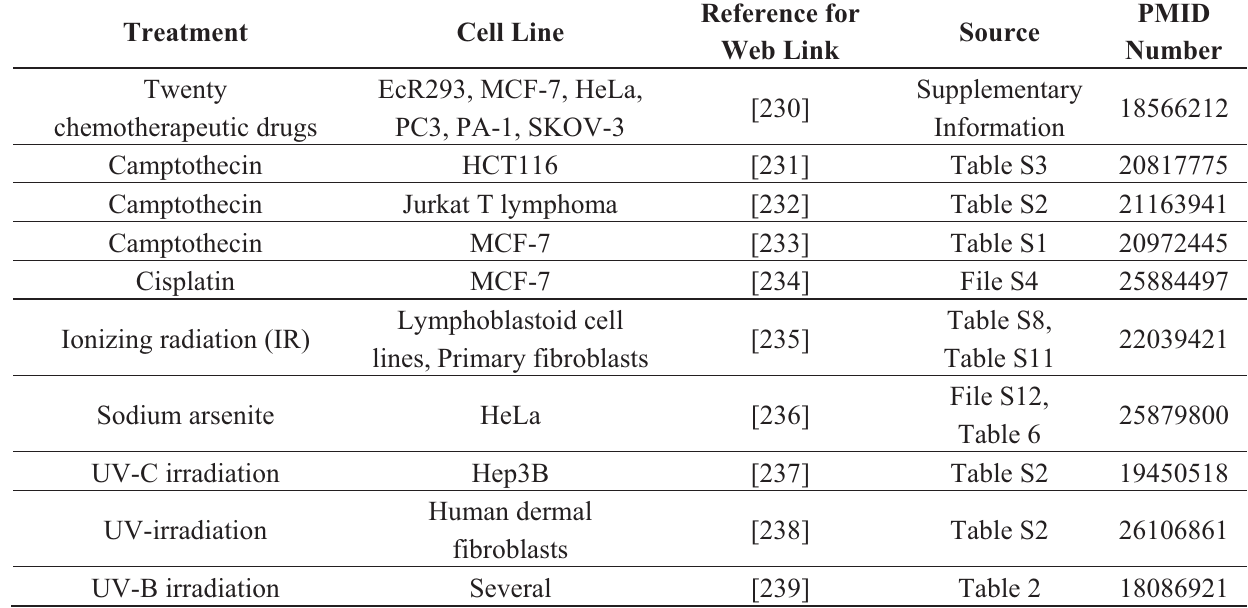
Table 2. Alternative splicing events affected by DNA damaging agents and identified by high-throughput screening. A web link address is provided with the source file. The reference for each study is provided as a PubMed Identification (PMID)